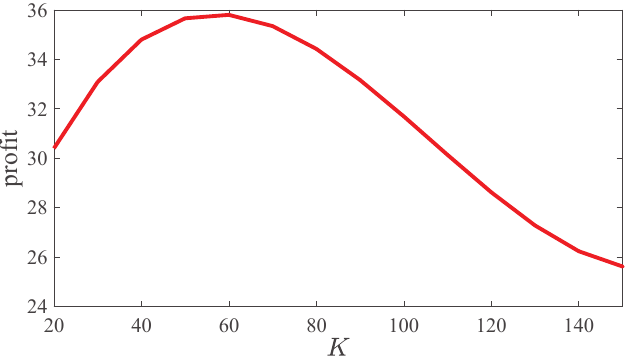
Figure 3. The profit vs. fleet size for a three parking region